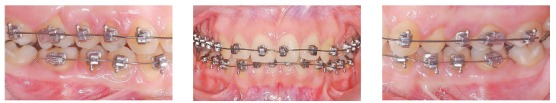
bonding according to plan to correct deep bite only by moving mandibular teeth.